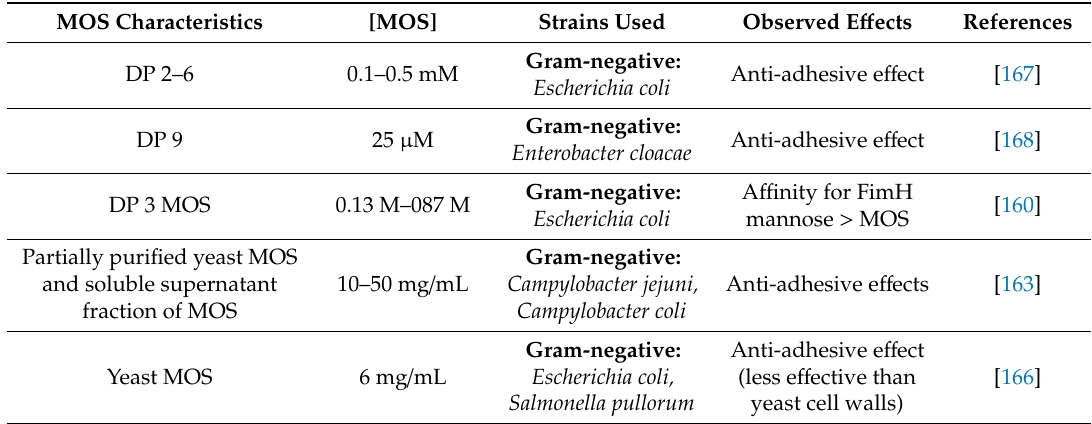
Table 6. Overview of the anti-pathogenic functionalities of MOS.